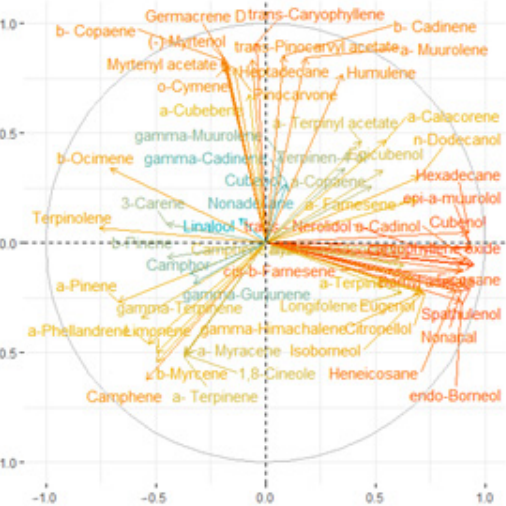
Figure 4. Loading plot connected to the score plot showing VOCs content variation among the investigated species.